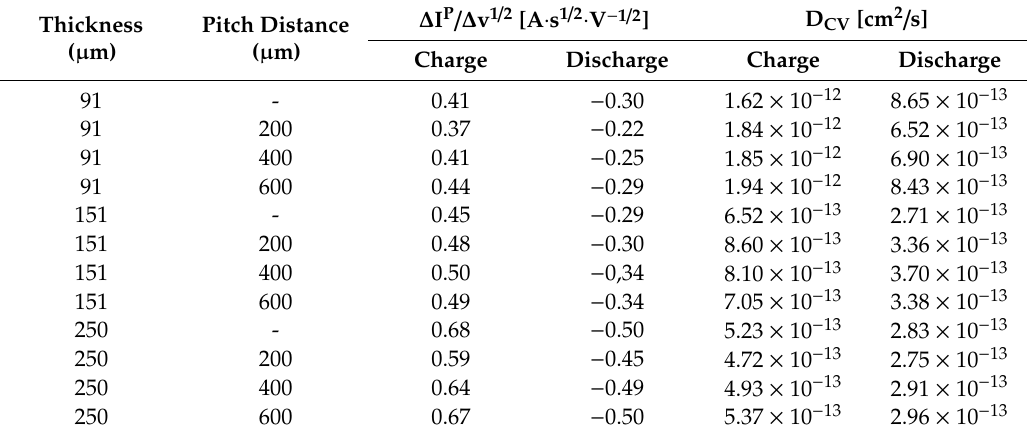
Table 3. Chemical di ff usion coe ffi cients of lithium-ion in unstructured and structured NMC 622 cathodes obtained from